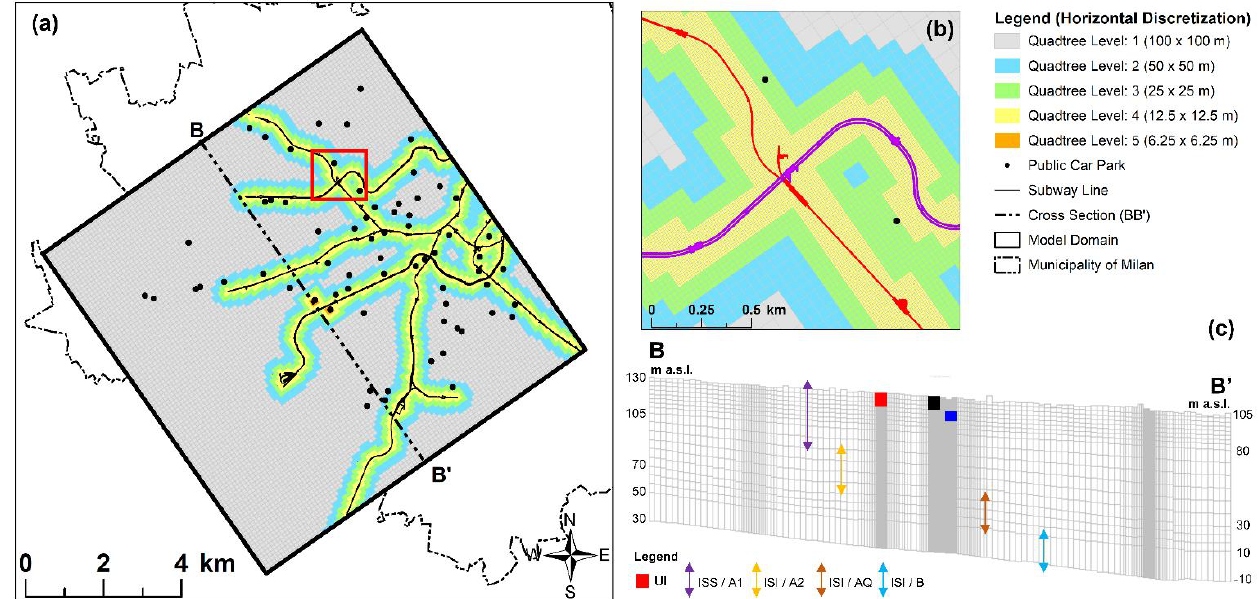
Figure 3. ( a ) Grid horizontal discretization; the red rectangle points to the sector area represented in Figure 3b; ( b ) example of quadtree refinement close to Lotto exchange station (see Figure 2); ( c ) grid vertical discretization. Please note that for Figure 3b, the same color coding of Figure 1b has been used for subway lines.